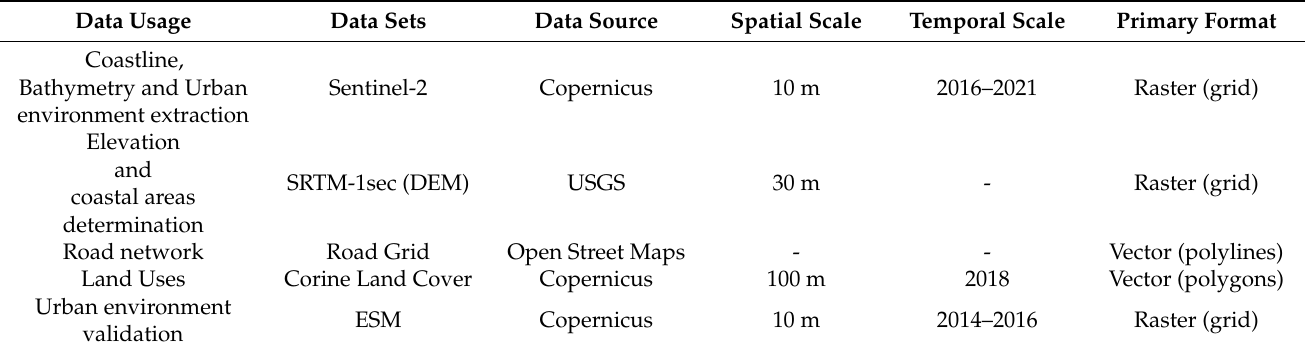
Table 1. Dataset used for Urban Mapping in Coastal Regions of Hellenic Volcanic Arc